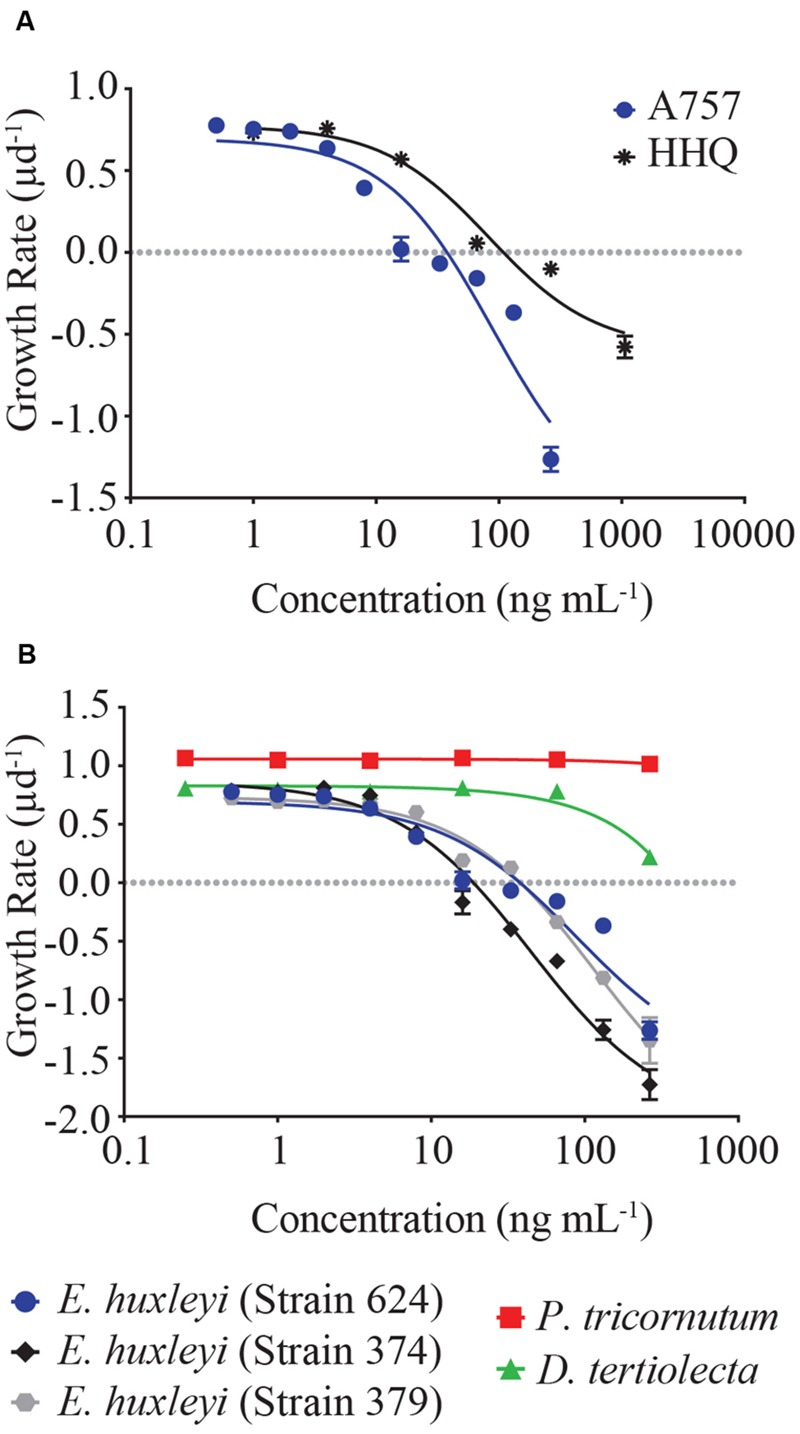
(A) Dose-response comparison of E. huxleyi (strain 624, axenic) growth rate in response to a gradient of extracted (labeled A757) and reference HHQ. (B) Dose-response curves of five different strains of phytoplankton in response to HHQ extracted from P. piscicida. Each symbol represents the mean of three independent replicates ± the standard deviation. IC50 values were calculated for each curve (see Table 1).